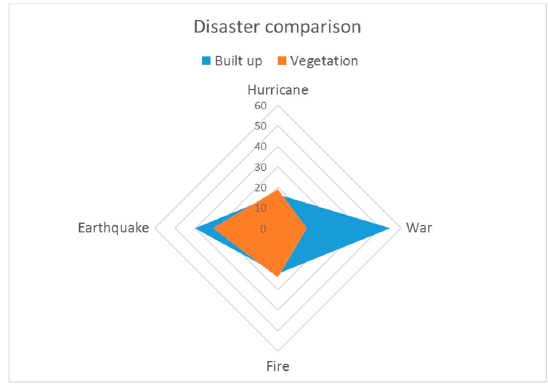
Figure 10. A comparison of built up vegetation land-use class responses to the four disasters.